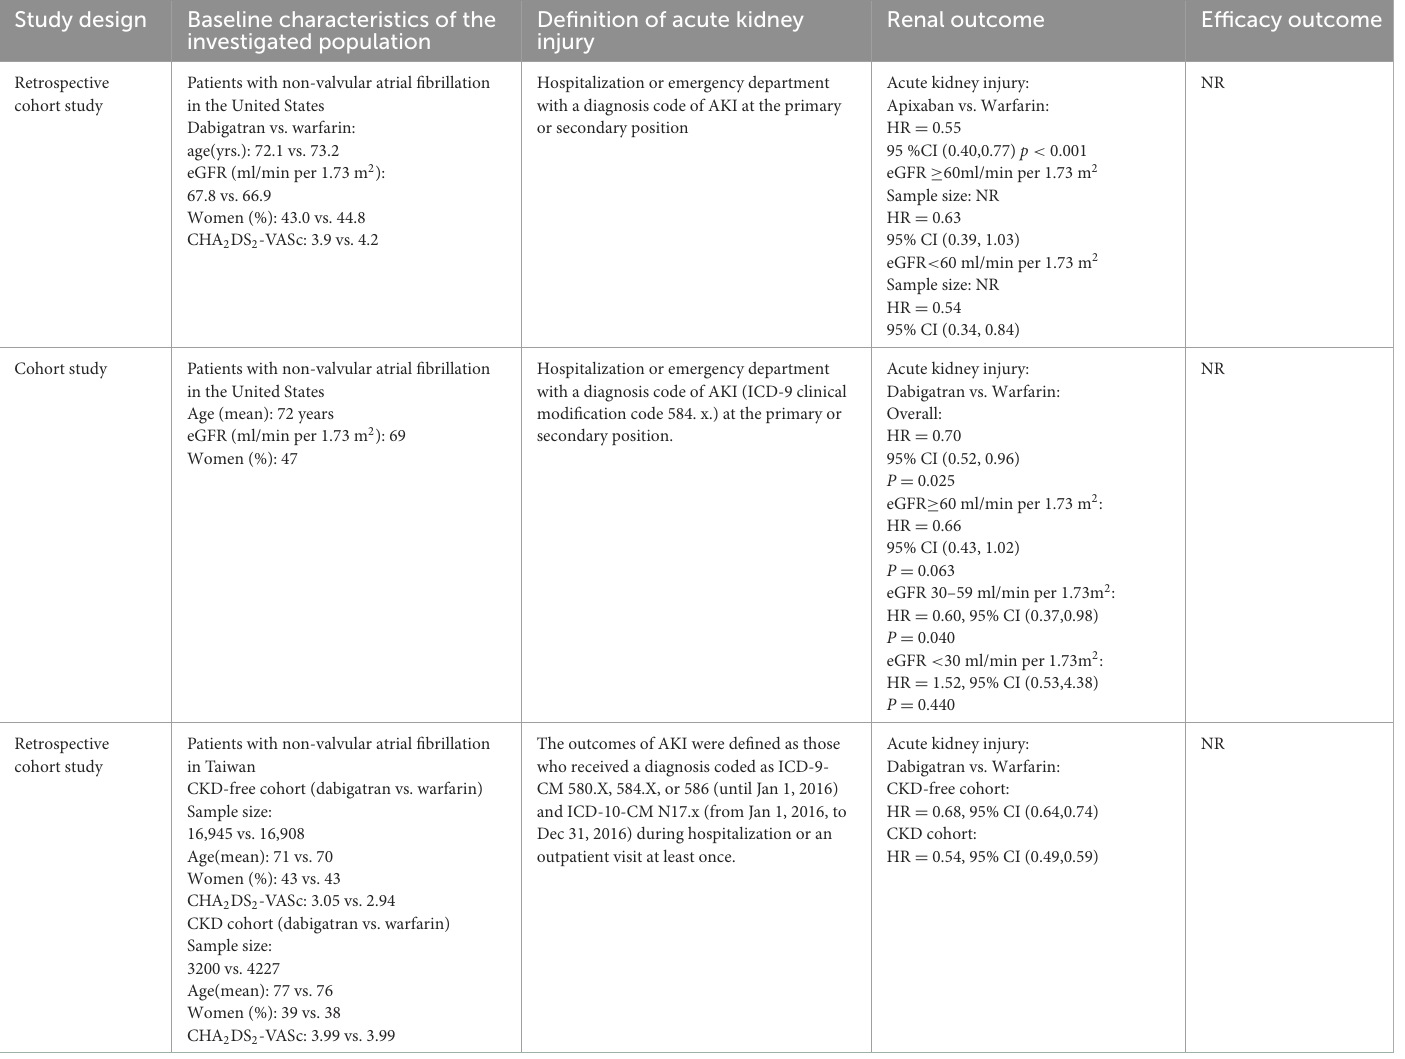
TABLE 2 Summary of studies comparing the risk of AKI induced by warfarin and dabigatran.